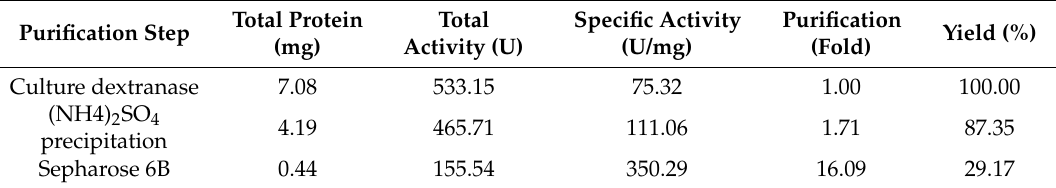
Figure 1. Relative dextranase activity of the supernatant ( a ) and the precipitate ( b ) with different ammonium sulphate saturation. Table 1. Parameters related to purification of the dextranase from Penicillium cyclopium .